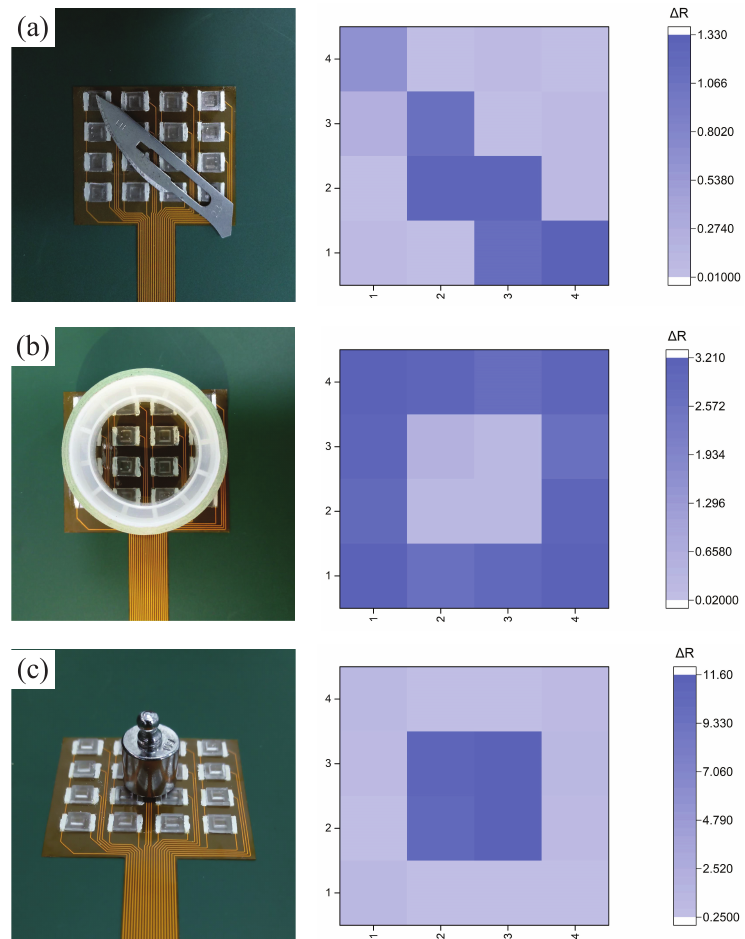
Figure 12. The mapping profile of the pixel signals generated by ( a ) a blade; ( b ) a roll of tape; and ( c ) a